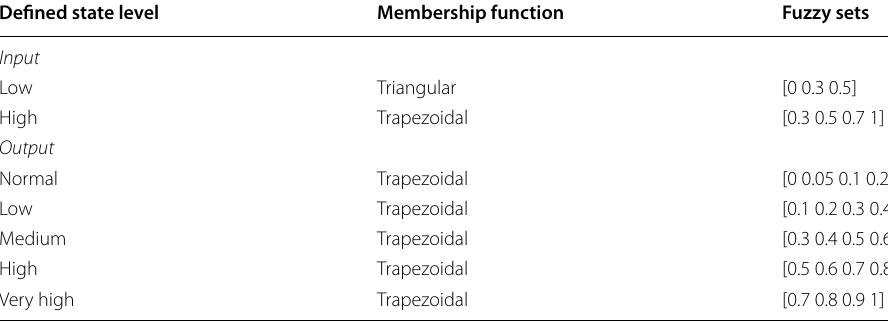
Table 4 Defined fuzzy sets for the input and output membership